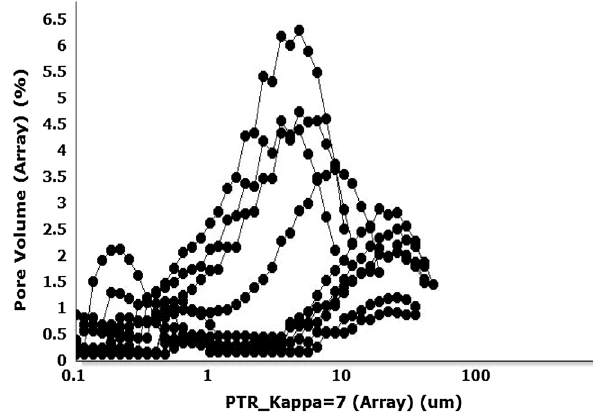
Fig. 5 Pore throat size distribution derived from NMR capillary pres- sure for kappa = 7